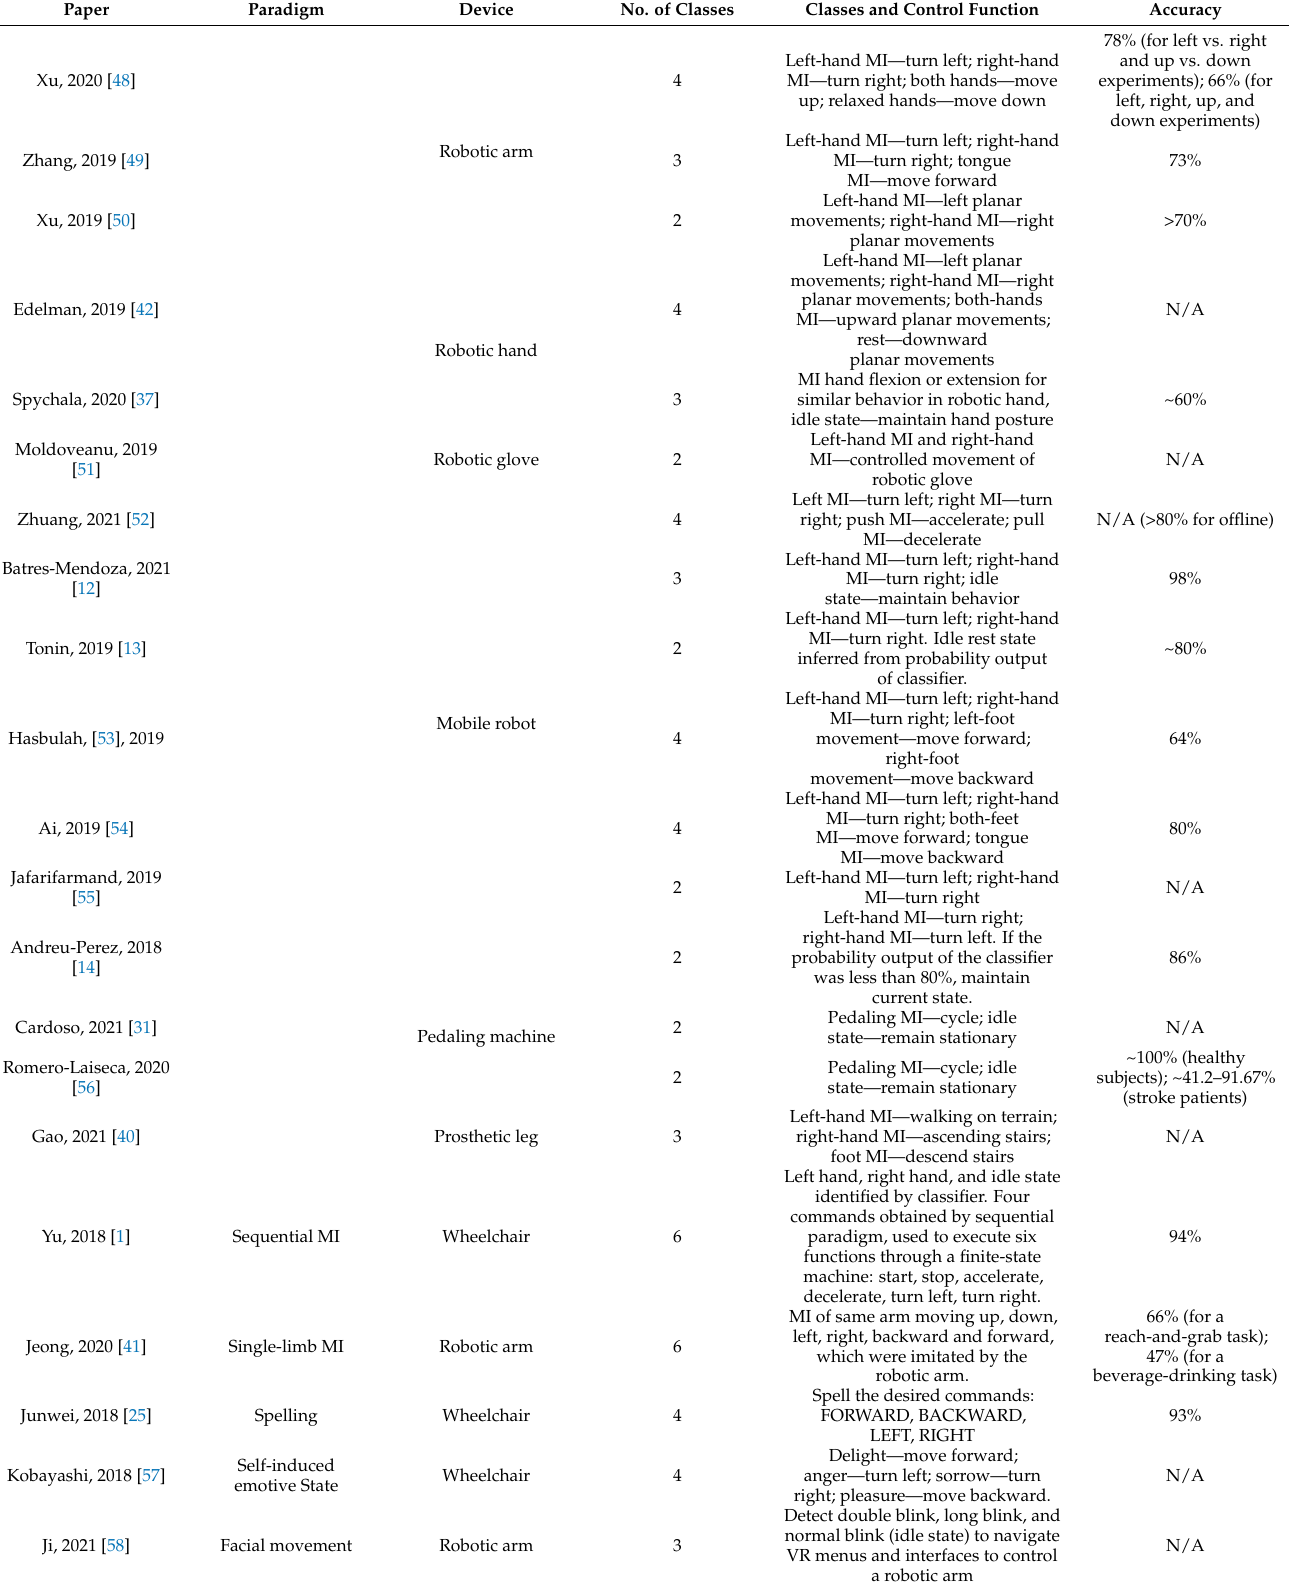
right; pleasure—move backward. Detect double blink, long blink, and normal blink (idle state) to navigate VR menus and interfaces to control a robotic